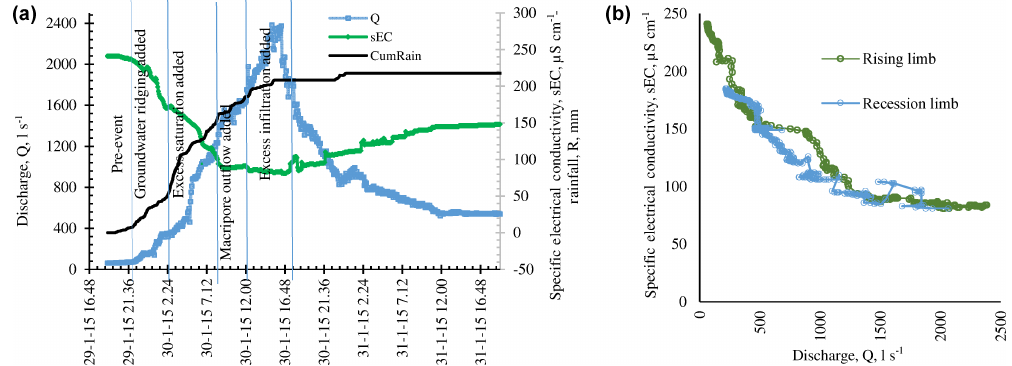
Figure 6. (a) Hydro-chemograph plot of the 29–31 January 2015 storm event and related hydro-geomorphological phases, during which the runoff components are progressively added, according to Table 3; (b) Q -EC hysteretic cycle of the storm